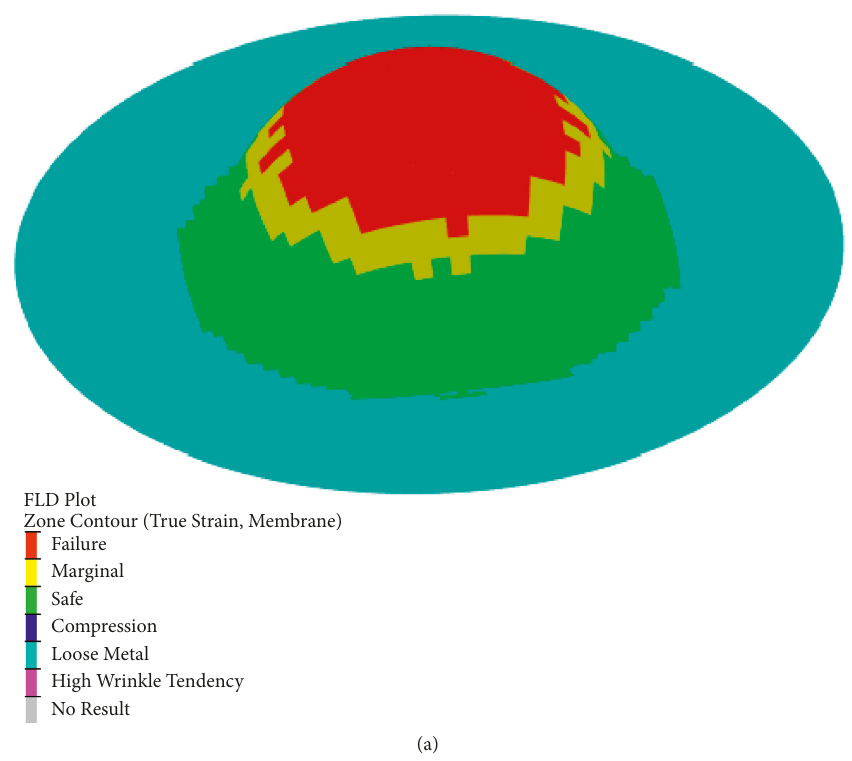
FLD Plot Zone Contour (True Strain,